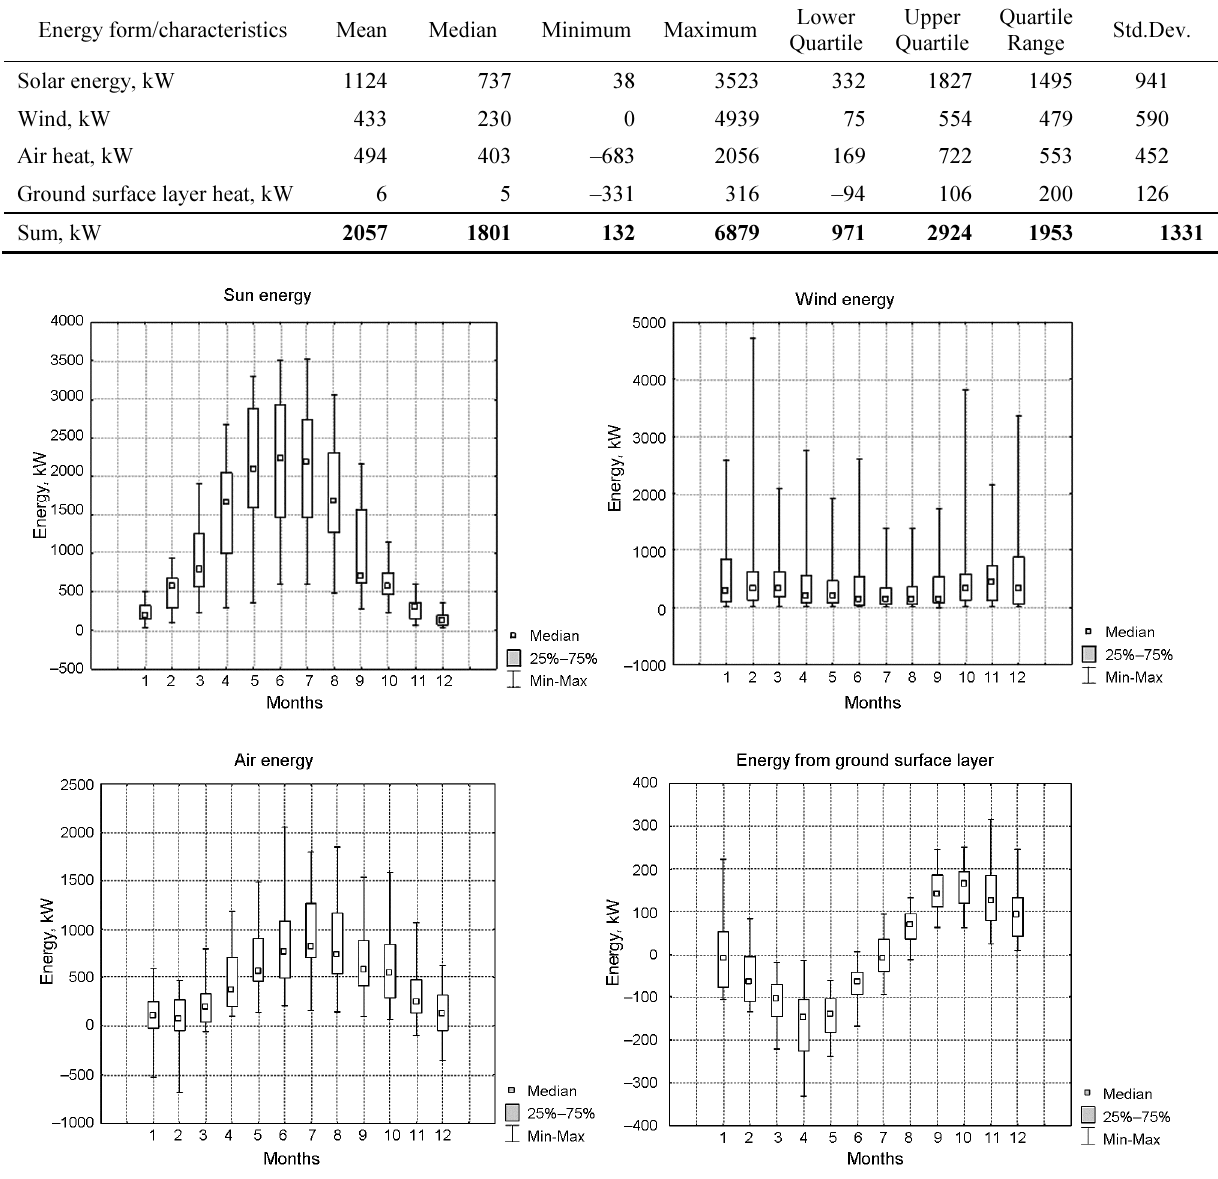
Table 2. Summary of RE flows statistics